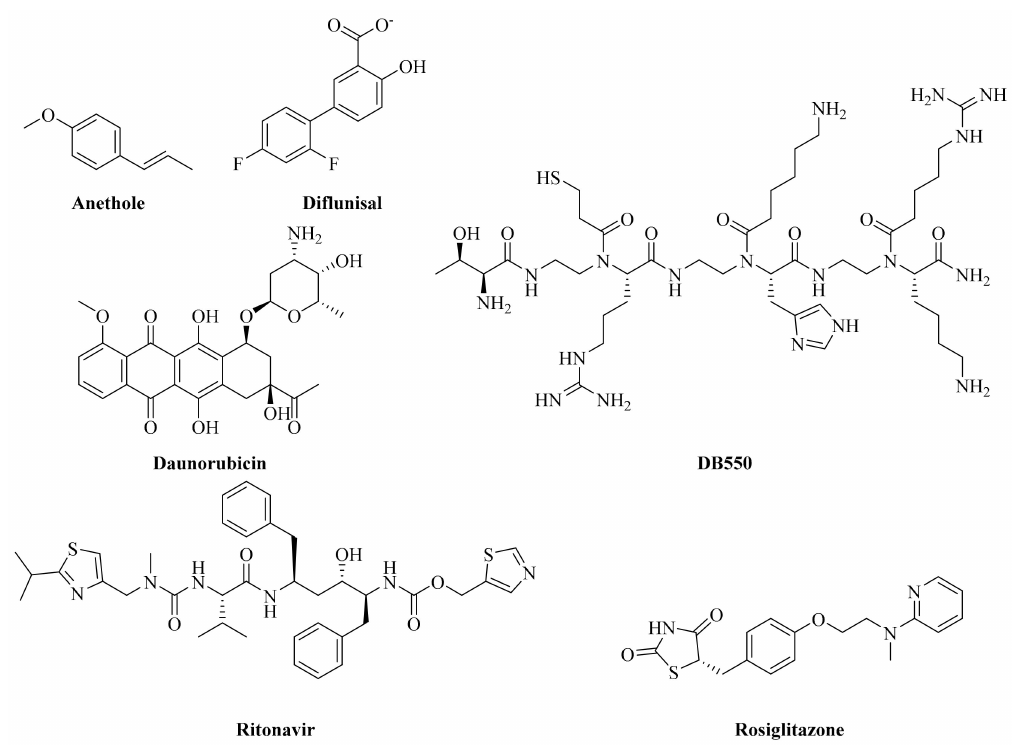
Figure 1. Structural formula of the reported inhibitors of phospholipase C gamma 1–cluster of di ff erentiation 95 (PLC γ 1–CD95) interactions